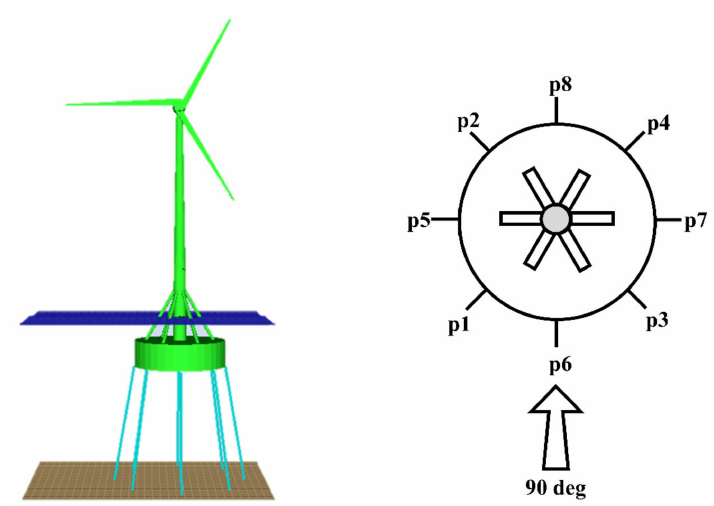
Figure 6. Numerical model with eight tension